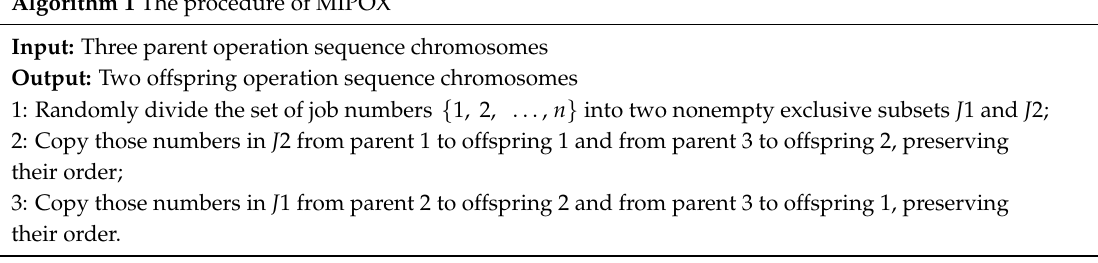
Algorithm 1 The procedure of MIPOX